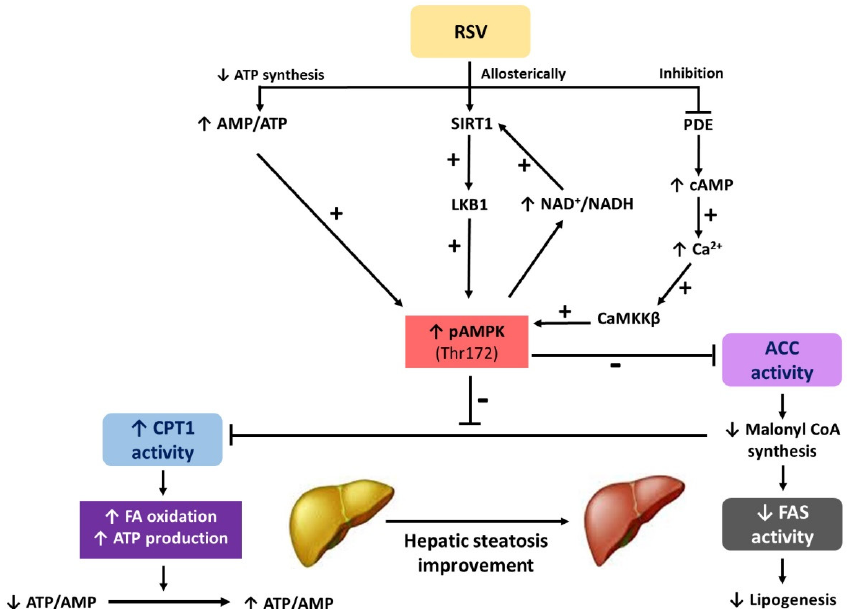
Figure 2. Effects of resveratrol (RSV) on hepatic steatosis improvement through 5 (cid:48) AMP-activated protein kinase (AMPK) activation. ACC: acetyl-CoA-carboxylase, AMPK: 5 (cid:48) AMP-activated protein kinase, AMP: adenosine monophosphate, ATP: adenosine triphosphate, cAMP: cyclic adenosine monophosphate, CaMKK β : Ca 2+ /calmodulin-dependent protein kinase kinase β , CPT1: carnitine